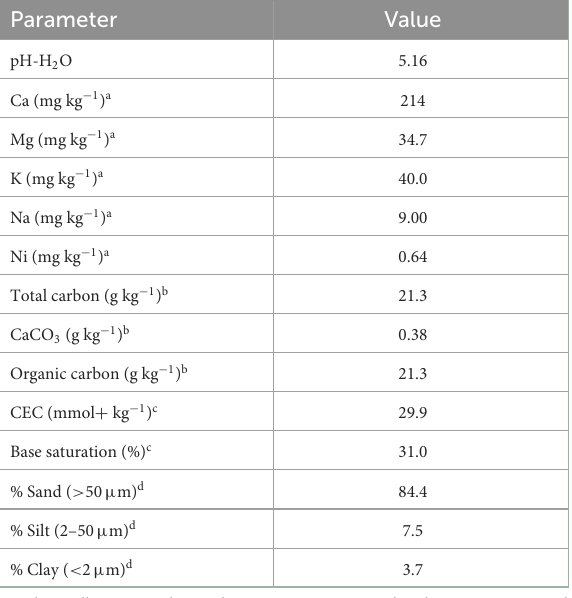
TABLE 1 Characteristics of the experimental